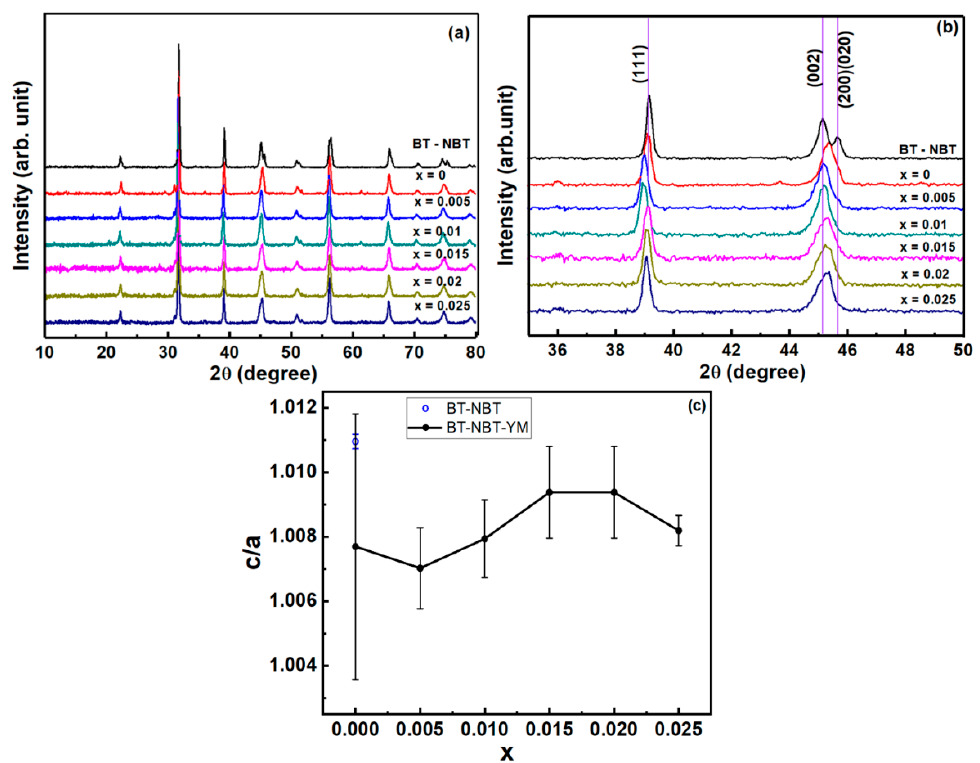
Figure 1. ( a ) XRD patterns of BT-NBT and BT-NBT-YM samples, ( b ) the magnified data for BT-NBT-YM samples, ( c ) the tetragonality c / a of samples from Pawley refinements